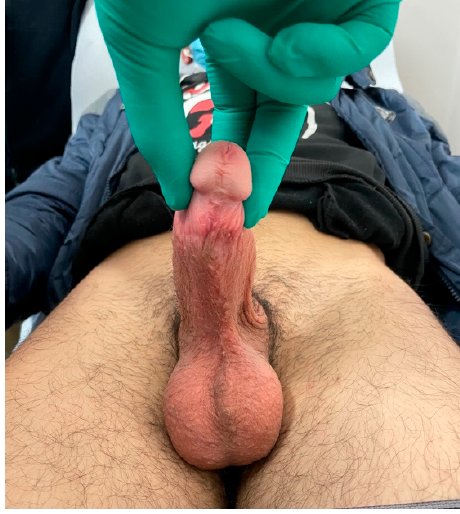
Figure 8. Final result at 6 month follow up.